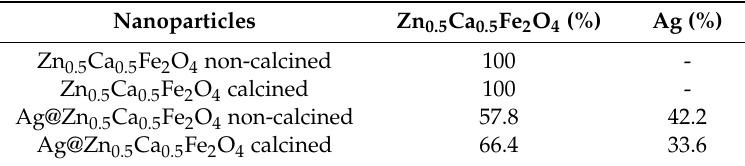
Table 3. Estimated percentage of silver in the nanoparticles obtained by